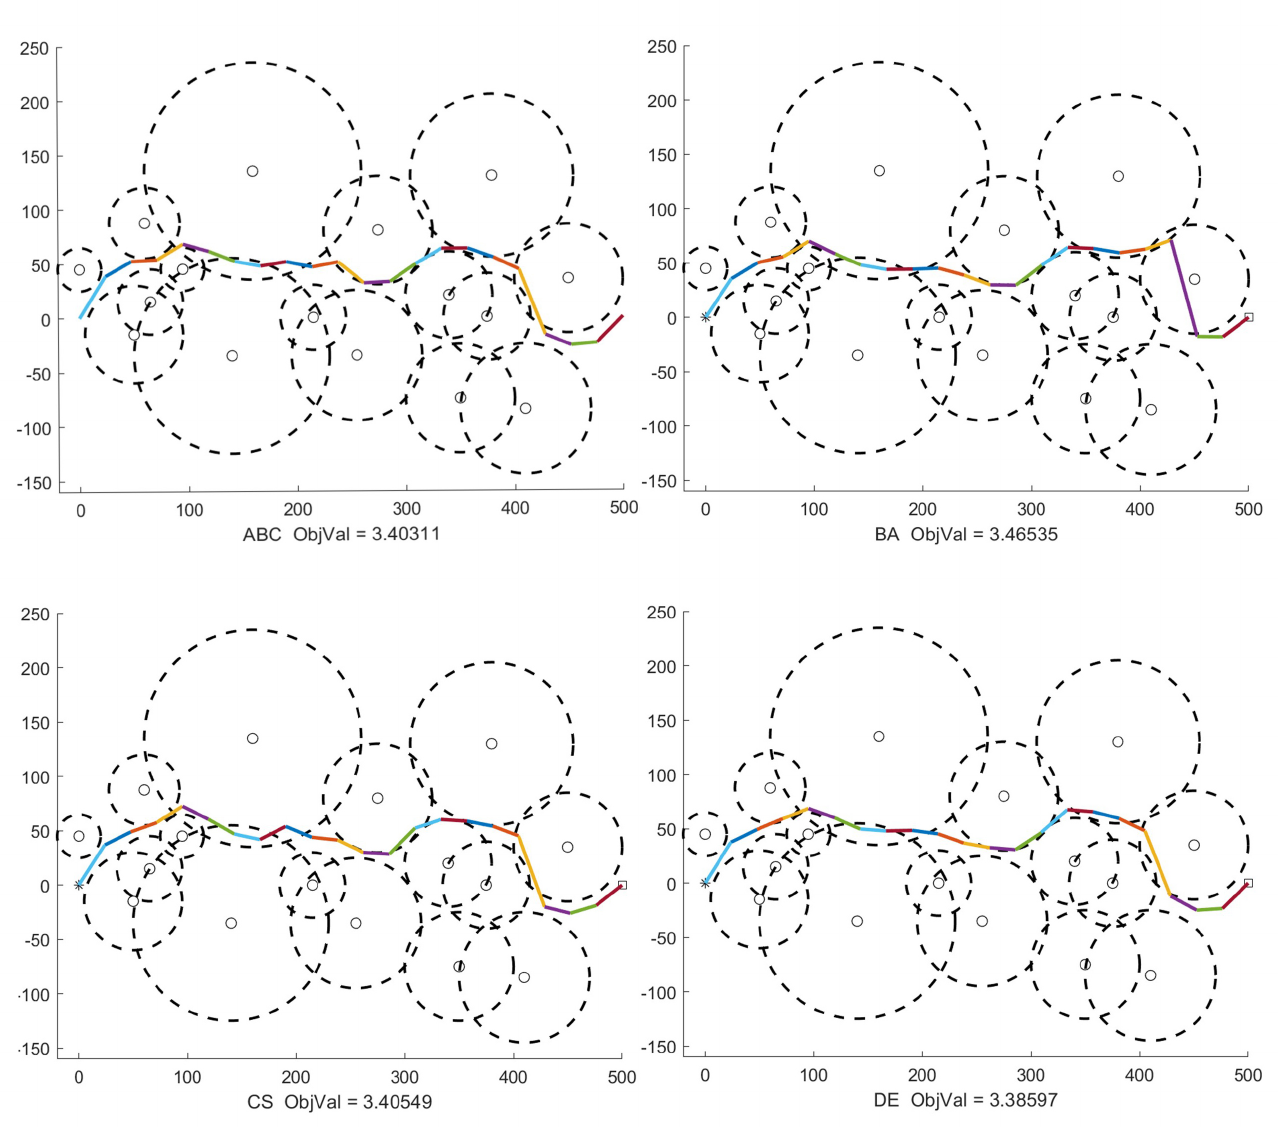
Figure 3. The comparison performance of different swarm intelligence algorithms including artificial bee colony algorithm (ABC), bat algorithm (BA), cuckoo search (CS), differential evolution (DE) for Case 8 with D = 20, N =